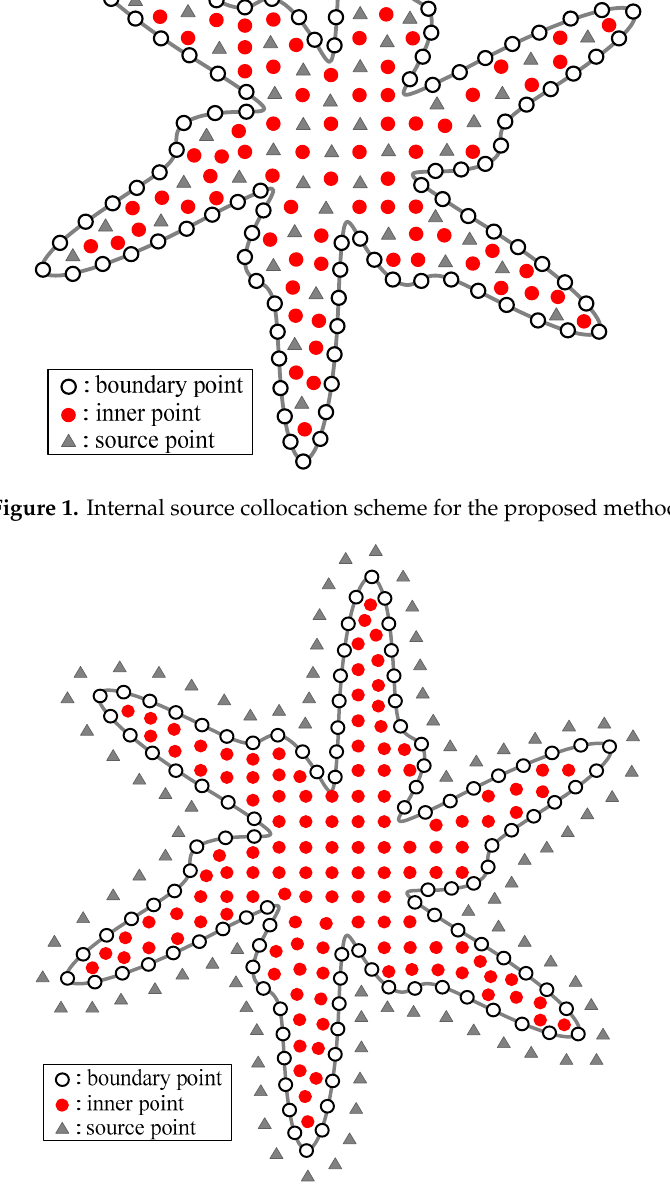
Figure 2. External source collocation scheme for the proposed method.